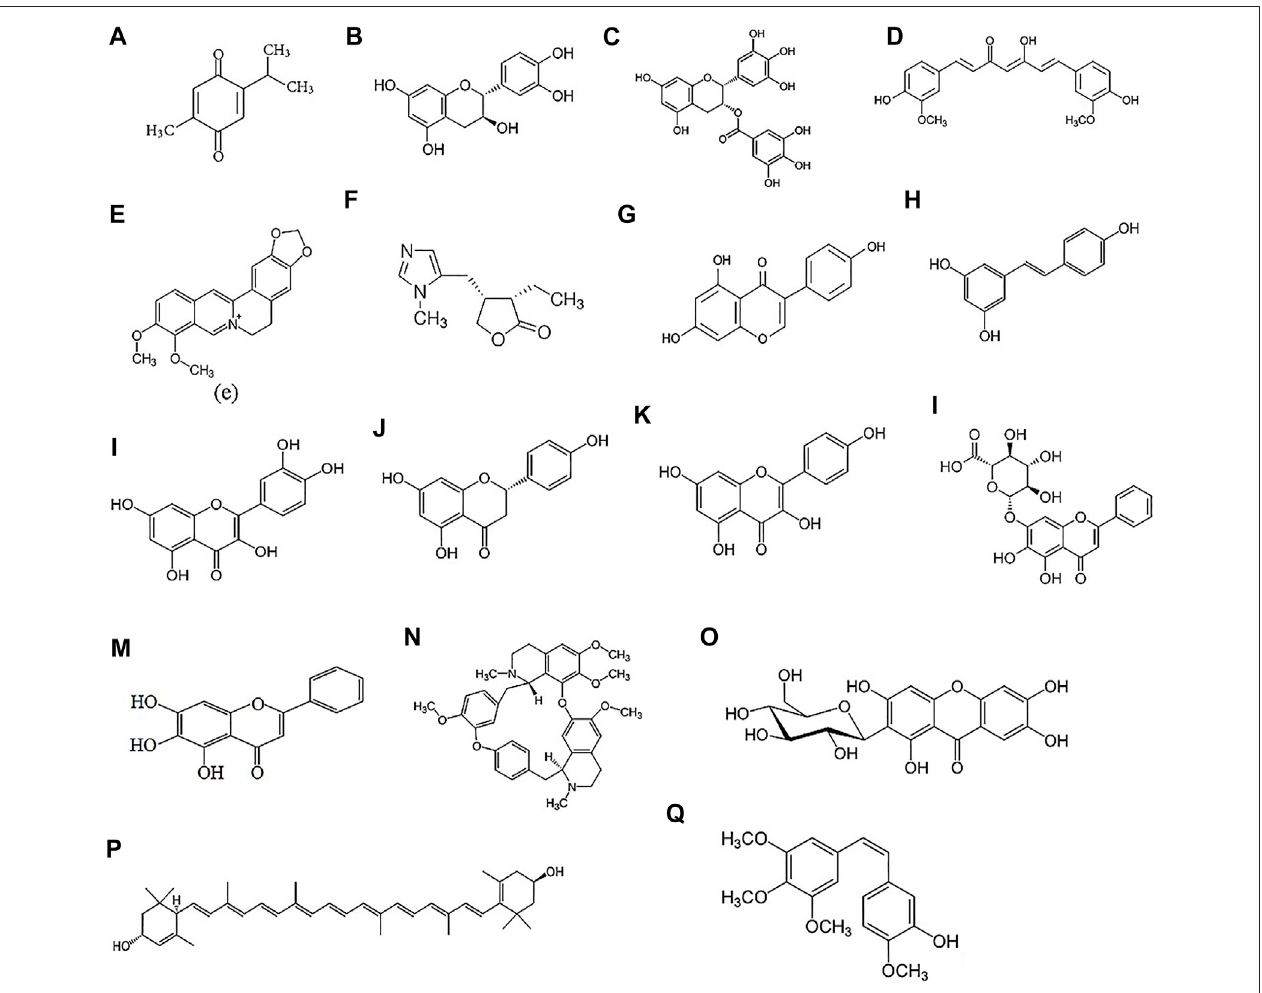
FIGURE 2 | Chemical structure of natural products: Thymoquinone (A) , Catechin (B) , Epigalloctatin gallate (C) , Curcumin (D) , Berberine (E) , Pilocarpine (F) , Genistein (G) ,Resveratrol (H) ,Quercetin (I) ,Naringenin (J) ,Kaempferol (K) ,Baicalin (L) ,Baicalein (M) ,Tetrandrine (N) ,Mangiferin (O) ,Lutein (P) ,CombretastatinA4 (Q) .